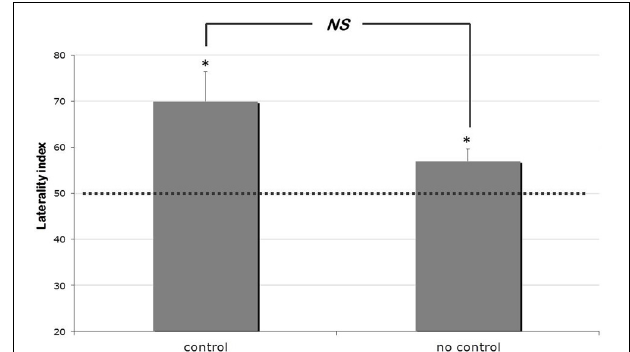
FIGURE 2 | Results of Experiment 1. Percentages of laterality index (means ± s.e.m.) scored by control and no-control group of chicks. The dotted line ( y = 50) represents chance level. ∗ indicates p < 0 .